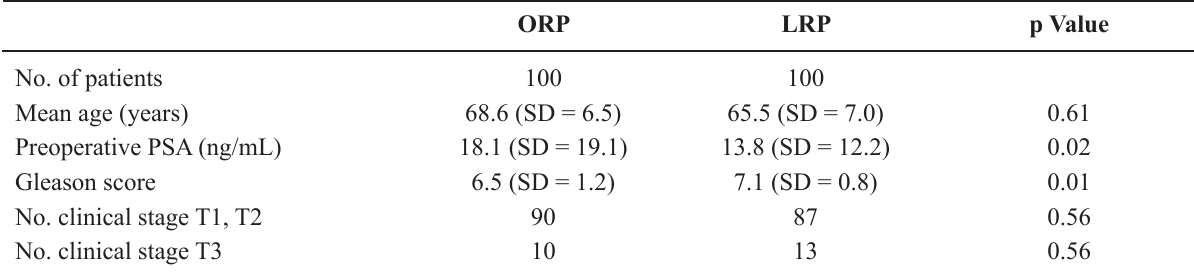
Table 1 – Patient characteristics in ORP and